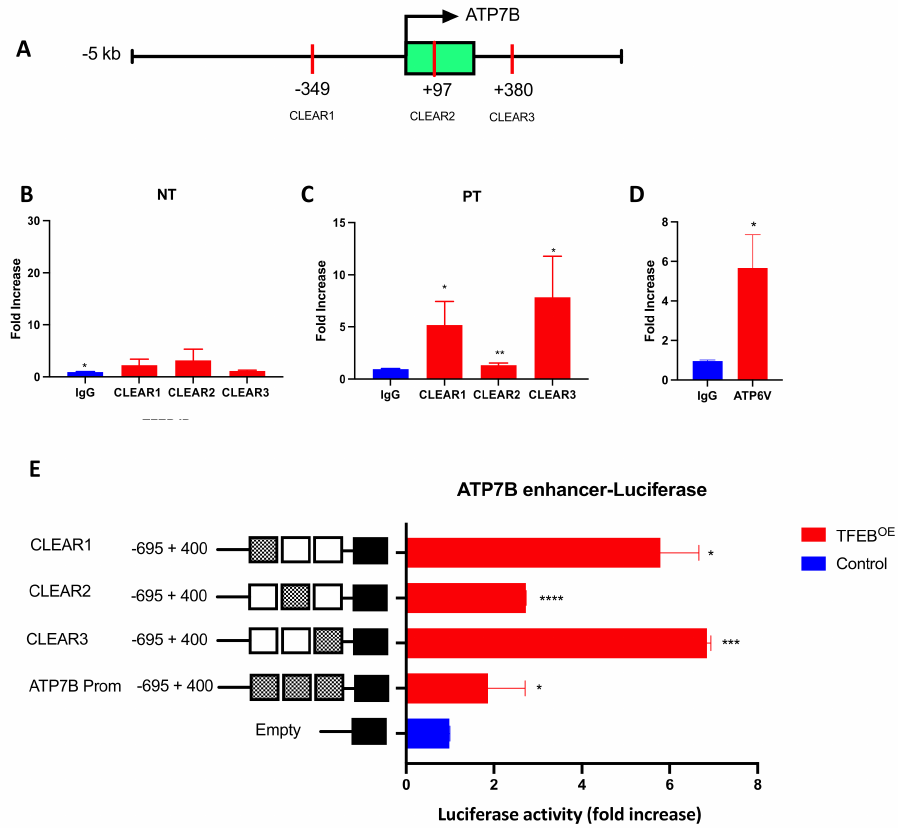
Figure 2. TFEB binds to ATP7B and activates its transcription in a Pt-dependent manner. ( A ) Schematic representation of the ATP7B proximal promoter ( − 5 kb from TSS) and first intron (+380 from TSS) where the CLEAR sites have been predicted with relative positions from the TSS. ( B , C ) Chromatin was isolated from IGROV-CP20 in untreated (NT) conditions ( B ) or upon 24 h exposure to 50 µ M Pt ( C ) and subjected to ChIP with antibody against endogenous TFEB or control IgG. PCR amplification revealed that TFEB-immunoprecipitated chromatin exhibited enrichment in ATP7B CLEAR sites in Pt-treated cells. DNA enrichment is expressed as fold increase compared to the control IgG (**, p < 0.01; *, p < 0.05, t -test; n = 3 experiments). ( D ) Amplification of bona fide TFEB target ATP6V from immunoprecipitated chromatin was used as positive control for the ChiP experiment (*, p < 0.05; t-test; n = 3 experiments). ( E ) The luciferase reporter constructs harboring the 3 CLEAR sites driven by the ATP7B promoter showed a significant increase in luciferase activity upon overexpression with a PLX3-TFEB (TFEB OE ) compared to the controls in cells treated with